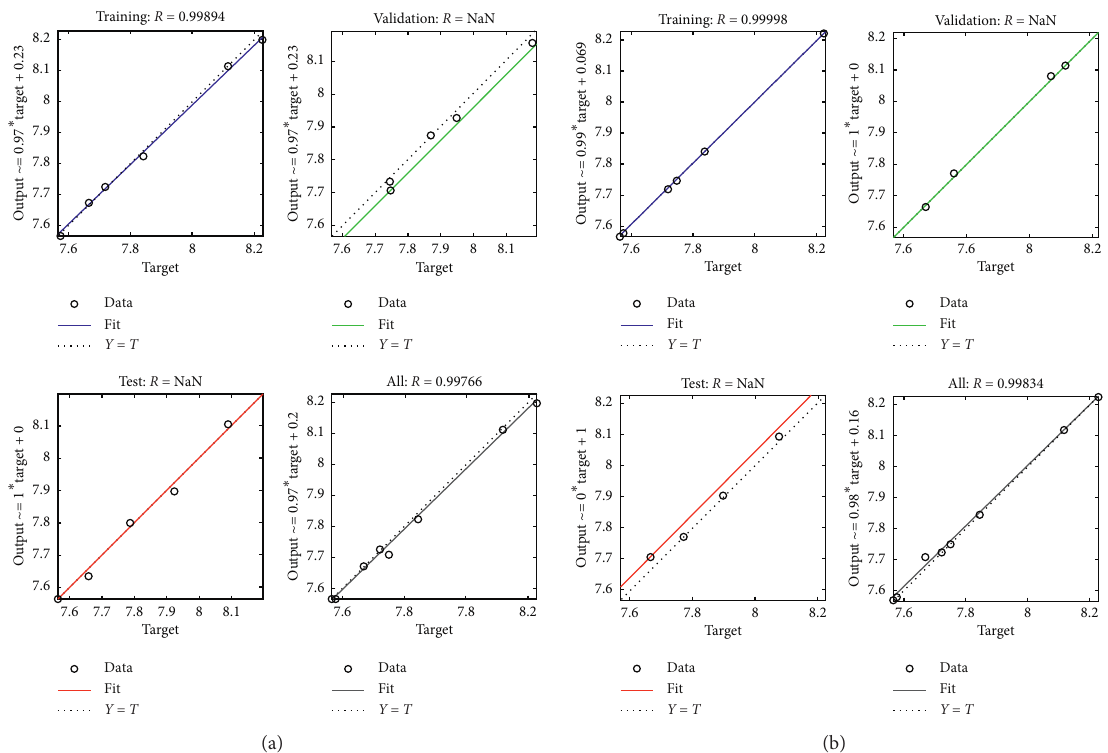
Figure 12: FNN model prediction of DO concentrations using (a) LULC and (b) combination of LULC and the eight (8) WQ